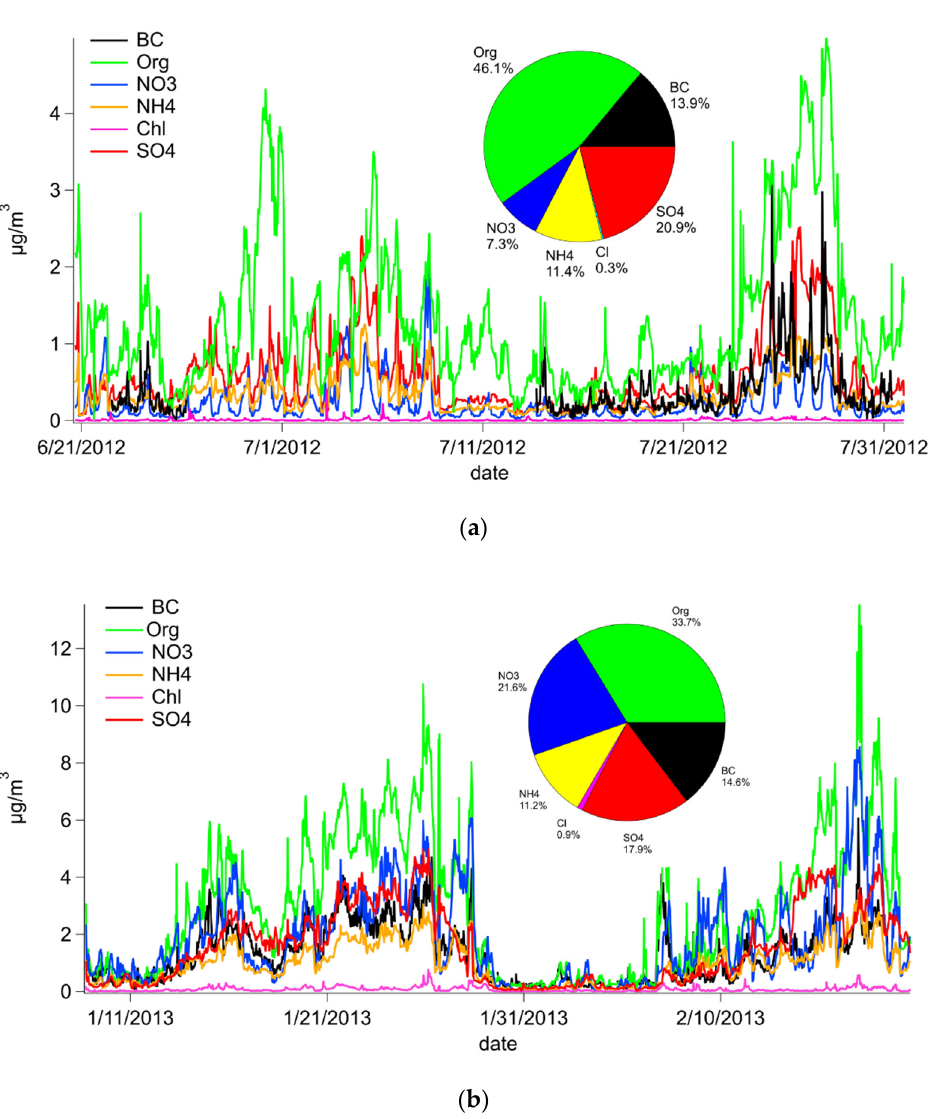
Figure 1. NR-PM 1 averaged 30 min time series and chemical composition of atmospheric aerosol during ( a ) summer campaign and ( b ) winter campaign.